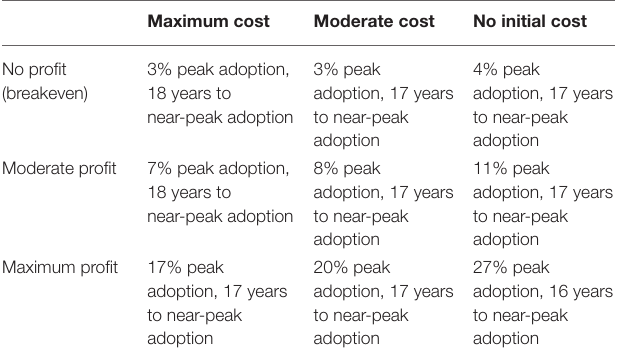
TABLE 3 | Predicted peak adoption levels and rates of adoption for nine cost-profit